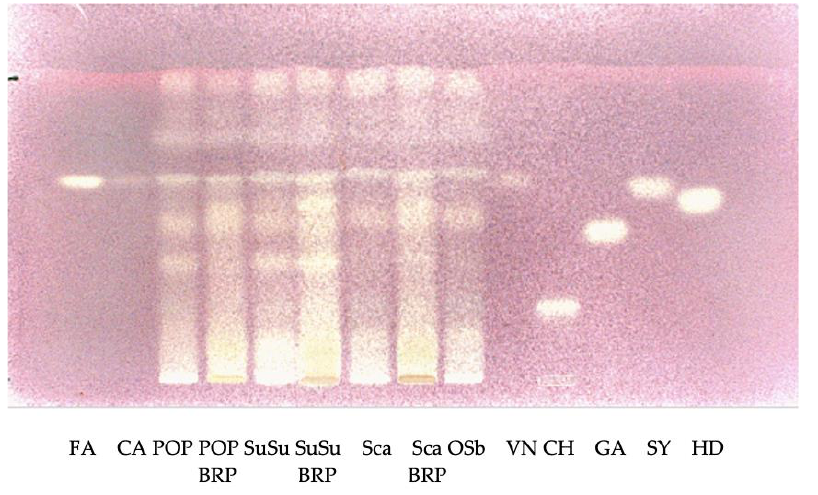
Figure 5. HPTLC patterns of the composition of phenolic compounds of the ethanol fraction of corn varieties detected at visible light after derivatization with DPPH solution. Standard phenolic acids are run in parallel. FA: ferulic acid, CA: coumaric acid, CH: chlorogenic acid, VN: vanillic acid, GA: